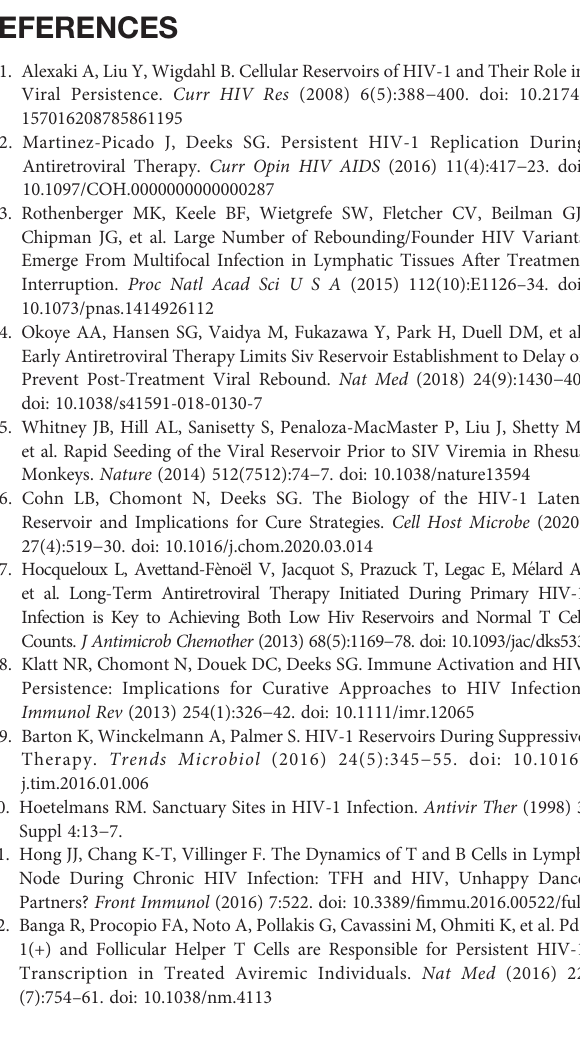
Supplementary Table 1 | Tableshowingthe characteristics of themonkeysused in this